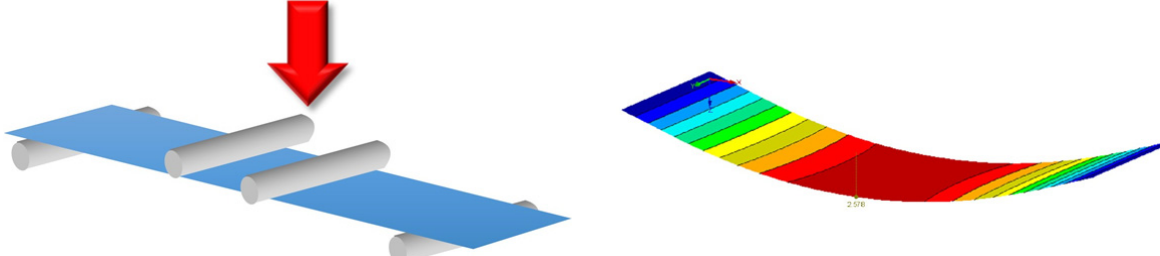
Fig. 6 Four-point bending principle test set-up, deflection of test